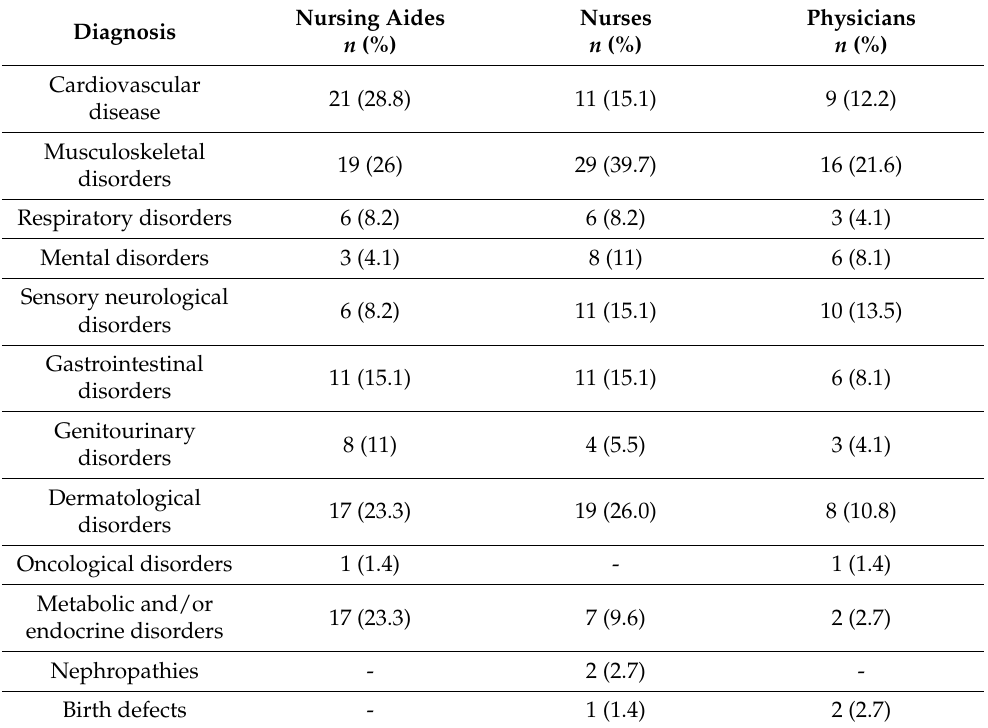
Diseases and physical disorders reported within the WAI: frequencies ( n ) and percentages